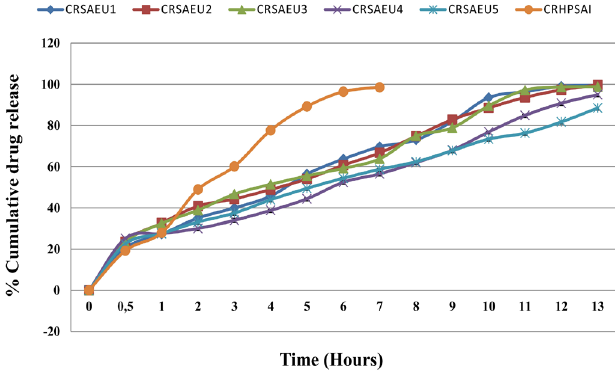
TABLE V - Release kinetics of carvedilol from microcapsules